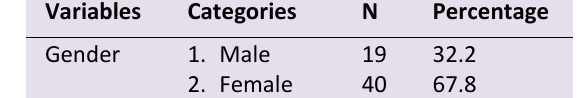
Table 1 . Demographic characteristics of the participants according to gender